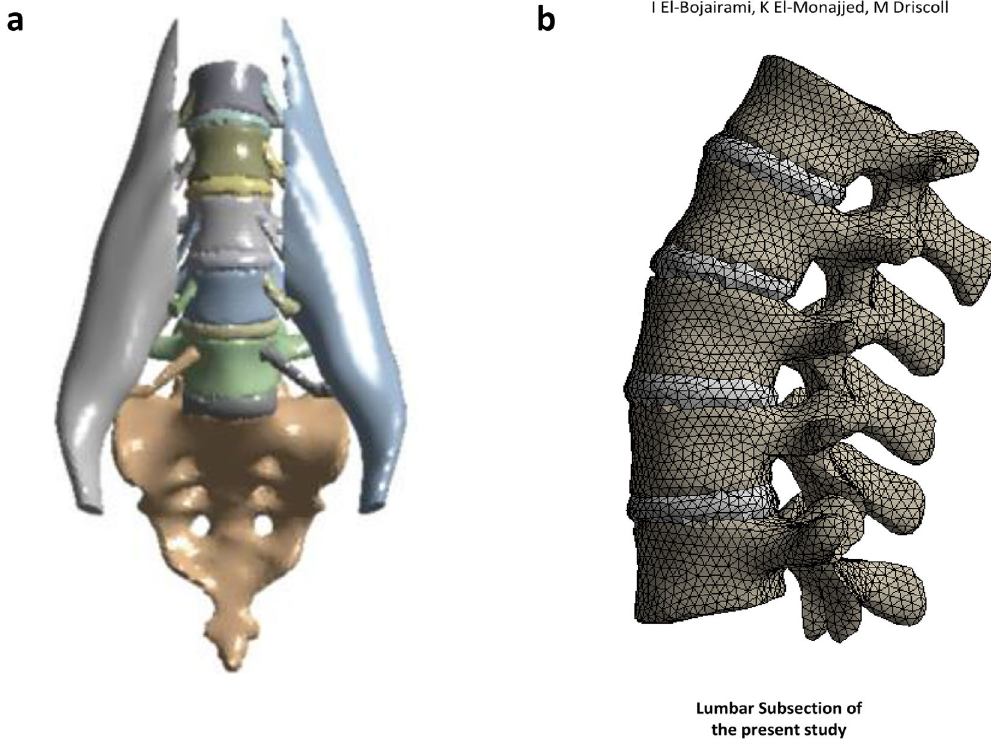
Figure 3. Lumbar spine finite element model. ( a ) Lumbar spine and psoas major muscle model isolated to perform the muscles and enclosed pressure validation. ( b ) Lumbar spine finite element model isolated to match the models against which validation was performed 17 (Models were developed using ANSYS, v.19.1, Canonsburg, Pennsylvania, United States, https ://www.ansys .com/).